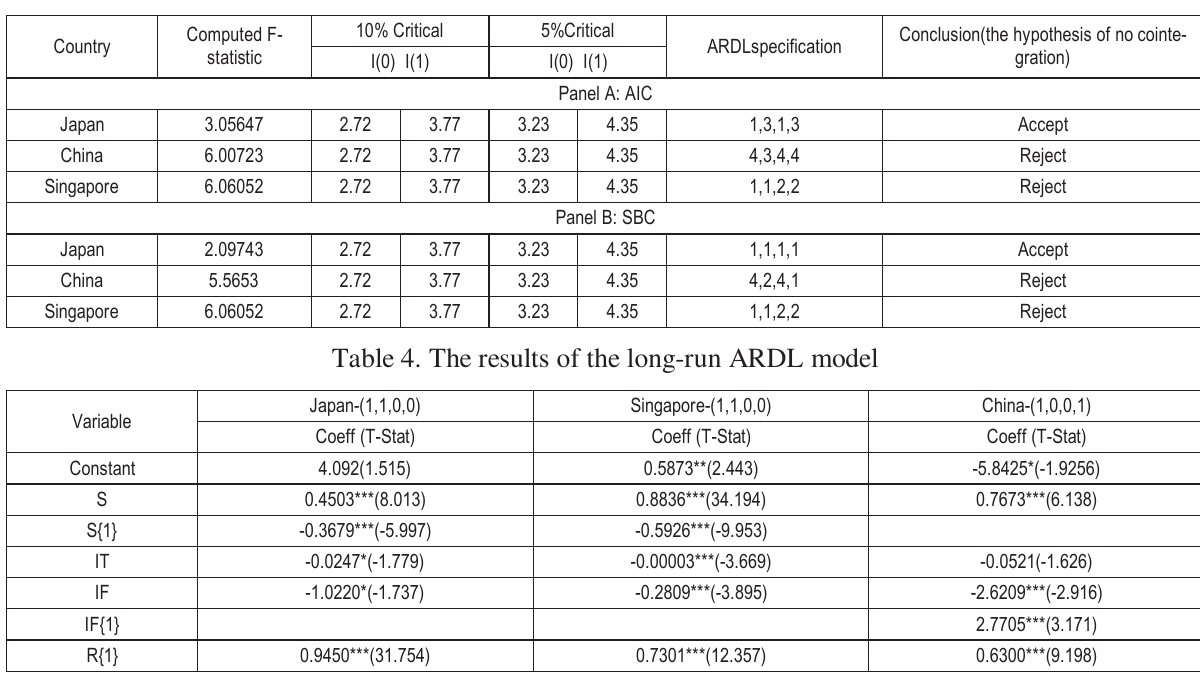
Table 3. The results of the bounds test for cointegration